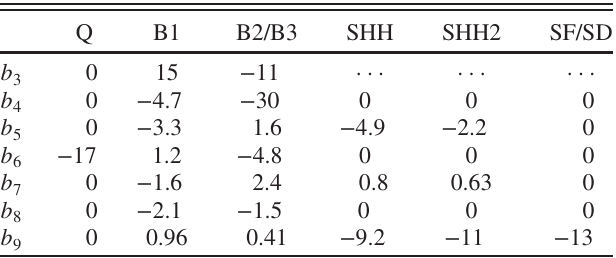
TABLE V. Systematic higher-order multipole errors in units of 10 − 4 (primary coils).